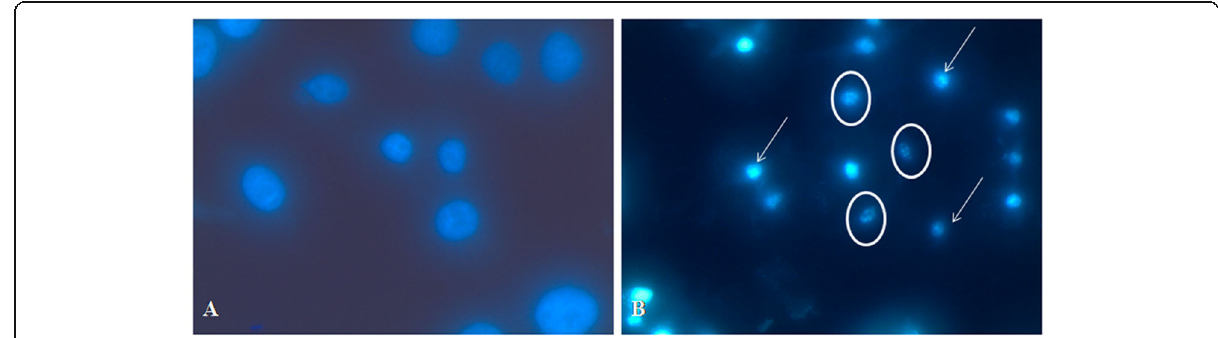
Fig. 9 a Negative control activity on skin cancer cell lines A431. b Anticancer activity of camptothecin gel on skin cancer cell lines